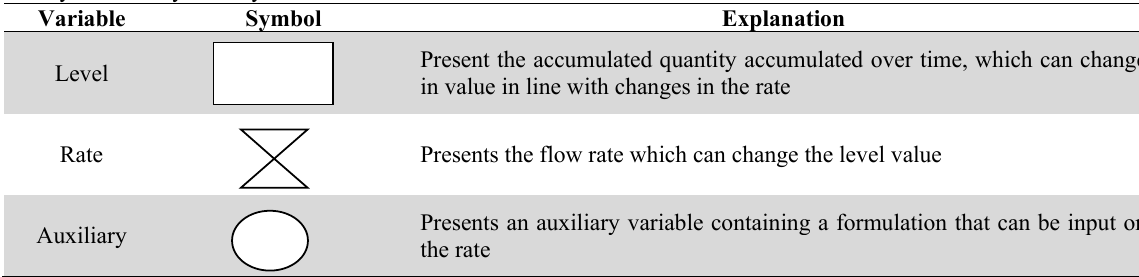
The Symbols in System Dynamics